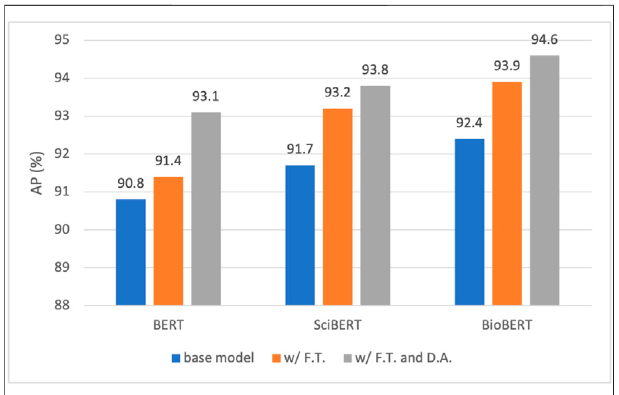
FIGURE 8 | Performance comparison of BERT, SciBERT, and BioBERT in AP under three training settings: base model, with fi ne tuning (F. T.), and with F. T. and data augmentation (D.